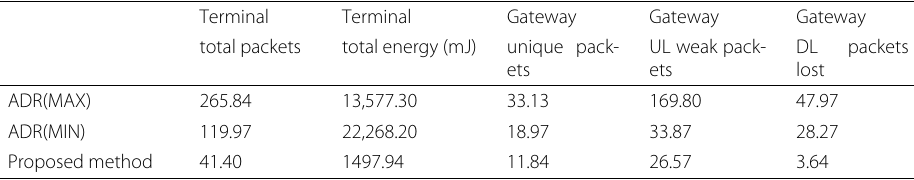
Table 4 Simulation statistics